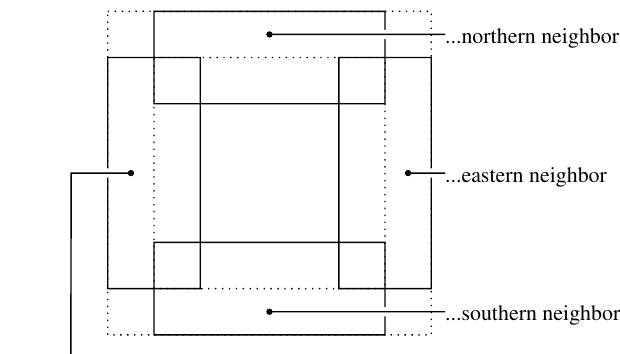
additional data structure for exchange with...